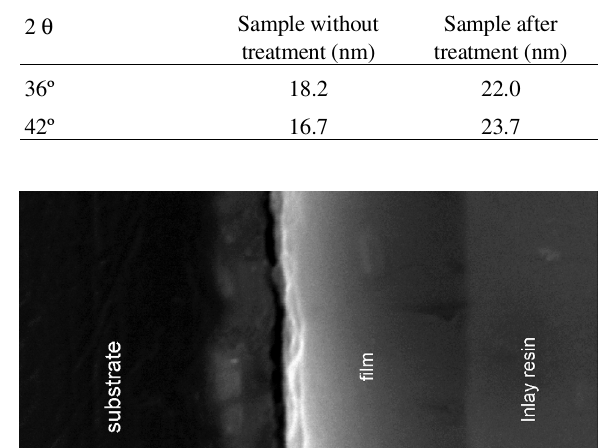
Table 2. Values of the grain size calculated by the Scherrer’s equation to 2 θ = 36º and 2 θ = 42º.